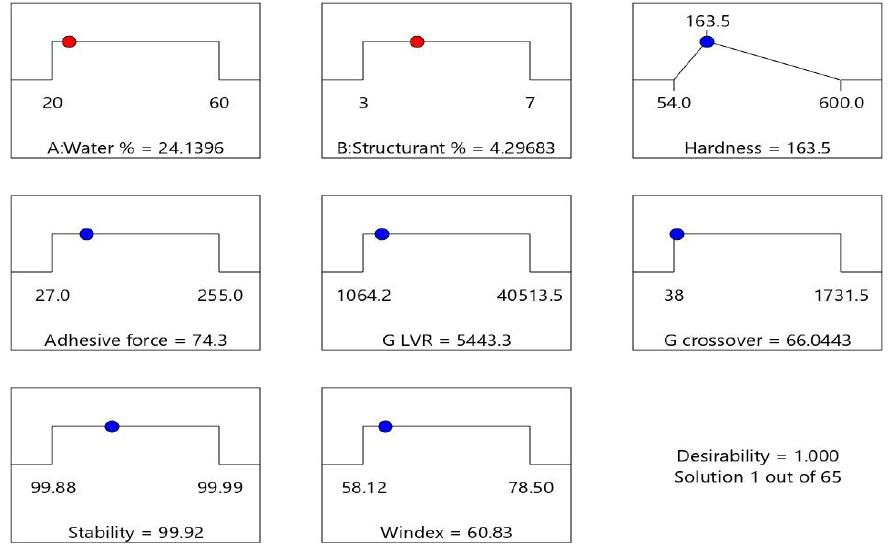
Figure 8. The calculated concentration ( ) of water (A) and shellac wax (B) and the responses ( ) of shellac wax-based oleogel emulsion suitable as low-fat margarine replacer, as given by Design Expert Software in the optimization test.